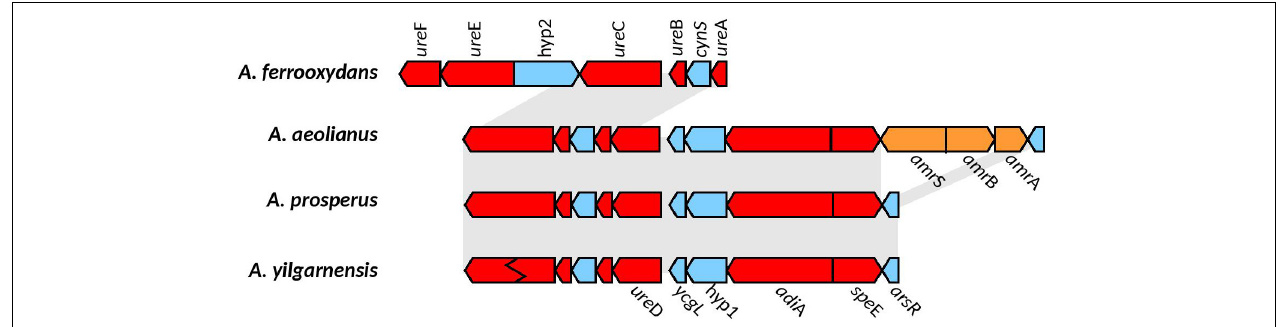
FIGURE 5 | Genomic context of the urease gene cluster in the Acidihalobacter spp. genomes. Gray background shows synteny between genomes; blue genes are found in all genomes; red shows genes hypothesized to be involved in acid and osmotic tolerance; genes in orange correspond to unique genes (only found in their respective genomes). Ziz-zag pattern indicates a frameshift mutation in the gene. Hyp1, hypothetical 1; Hyp2, hypothetical 2; cyn S, cynanate hydratase; ycg L, protein YcgL; ars R, arsenic resistance transcriptional regulator; amr S, AmmeMemoRadiSam system radical SAM enzyme; amr B, AmmeMedoRadiSam system protein B; amr A, AmmeMedoRadiSam system protein